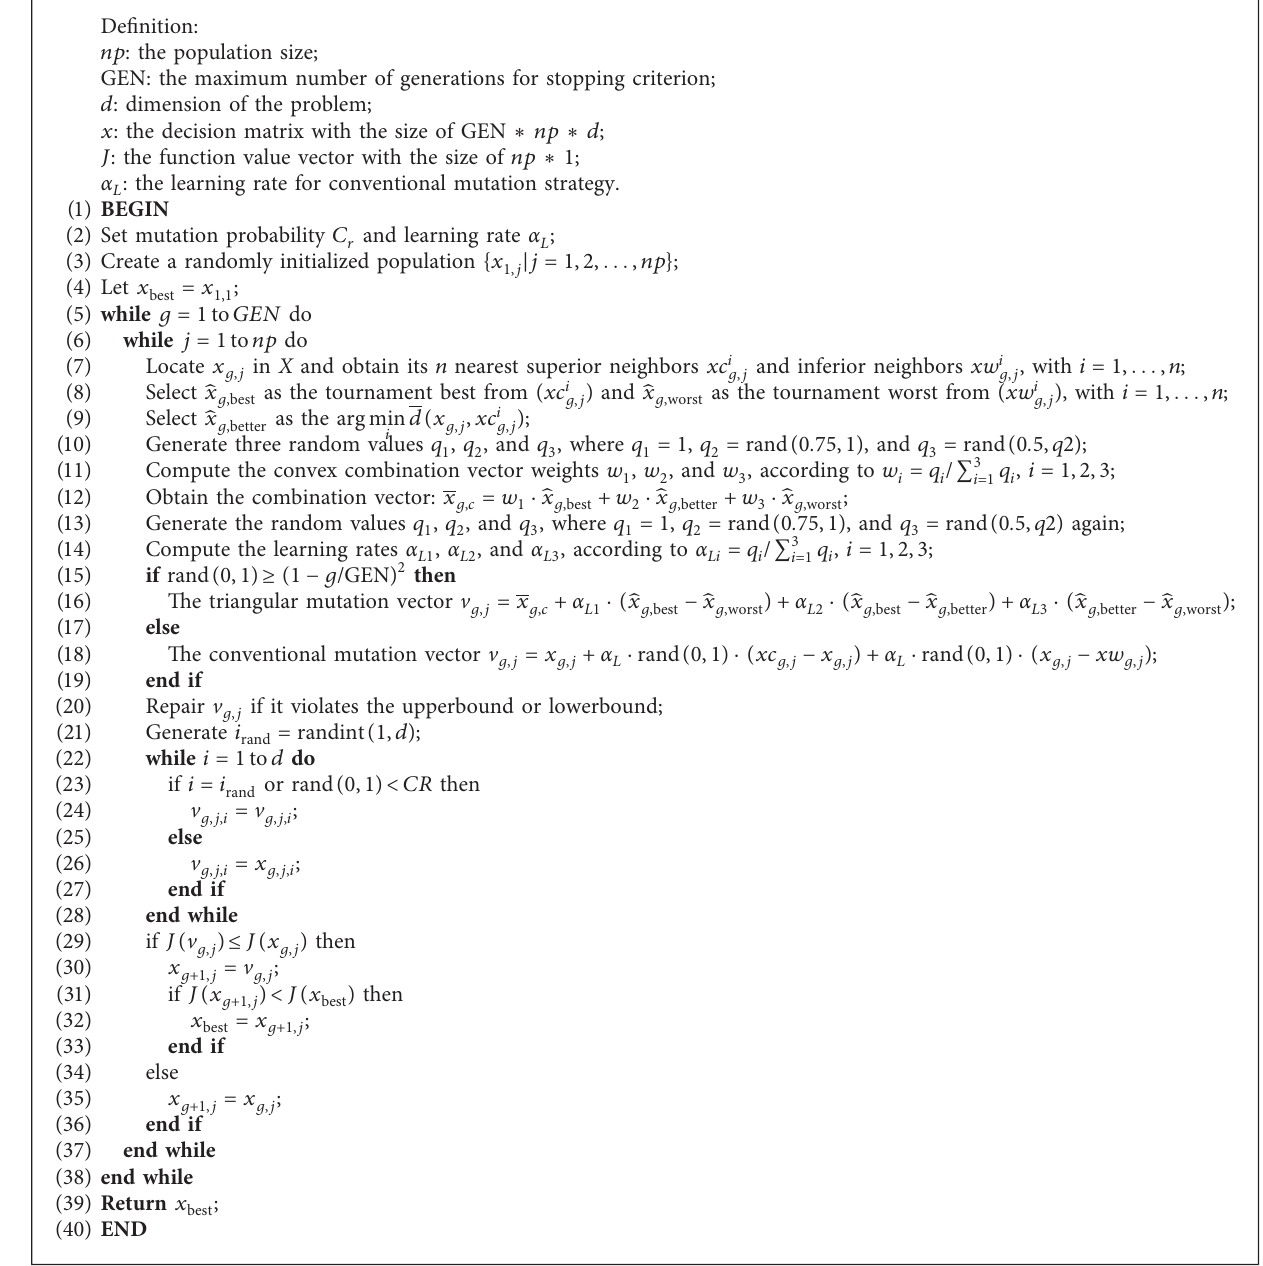
A LGORITHM 1: Pseudocode of the DE algorithm with combined mutation